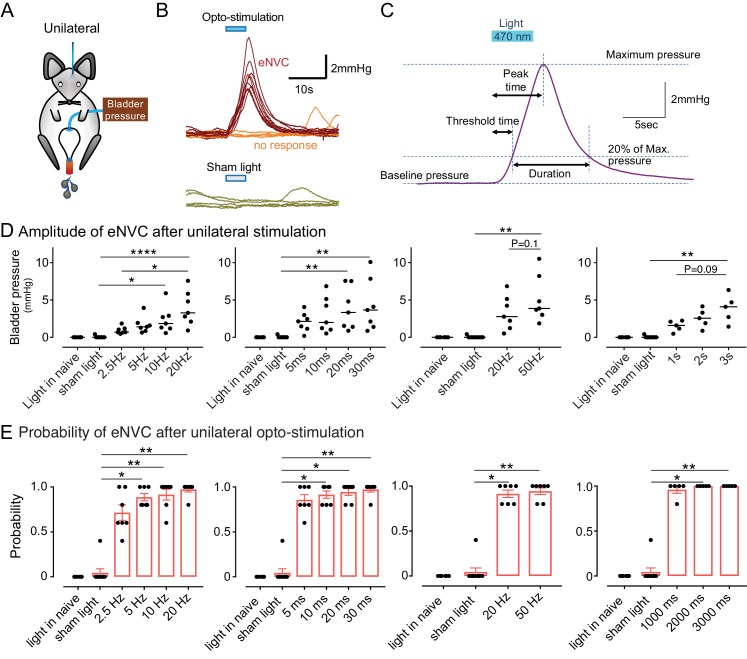
Phasic optoactivation of BarrCRH evokes bladder contractions.(A) Bladder pressure recordings with unilateral opto-activation (B) Phasic opto-activation (20 ms x 20 Hz, 5 s) of BarrCRH neurons evoked non-voiding contractions (eNVCs, with the bladder ~half full, static). These eNVCs had a stereotyped shape and a relatively constant latency. In addition, there were ‘failures’ where no response was evoked by an identical stimulus. (C) Parameters of BarrCRH evoked non-voiding contractions. Threshold calculated at 20% of the amplitude, duration was measured at the threshold pressure. The latency was taken as the time from start of stimulation for the pressure to reach threshold. (D) The amplitude of eNVC increased with stimulation frequency (pulse length 20 ms for 5 s) and pulse duration (at 20 Hz for 5 s) (n = 7 mice). Higher frequencies of stimulation (50 Hz x10ms) did not substantially increase eNVC amplitude. Single longer light pulses (1–3 s) could also generate graded eNVCs. (E) The probability of generating an eNVC increased with stimulation frequency (pulse length 20 ms for 5 s) and pulse duration (frequency 20 Hz for 5 s). Longer light pulses (1–3 s) also reliably generated eNVCs. (RM-ANOVA with Dunnett’s post hoc or Friedman's test, *p<0.05, **p<0.01, ****p<0.0001). Source data in Figure 3—source data 1.Figure 3—source data 1.Data for 'Phasic optoactivation of BarrCRH evokes bladder contractions'.